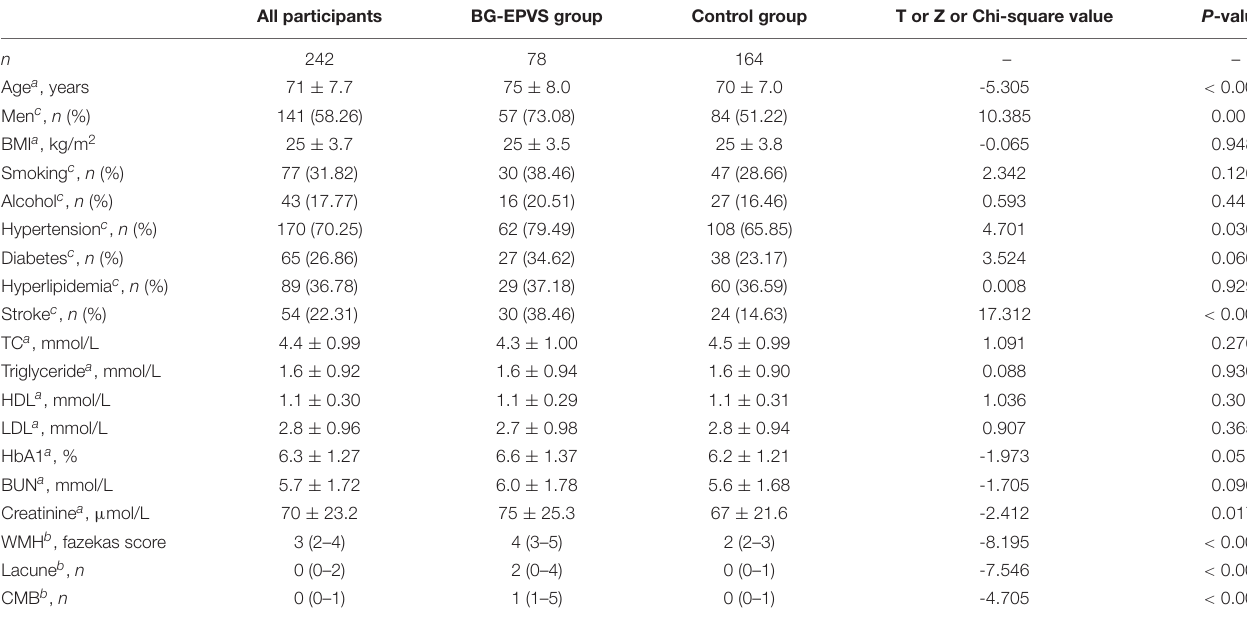
TABLE 1 | General clinical characteristics of participants.